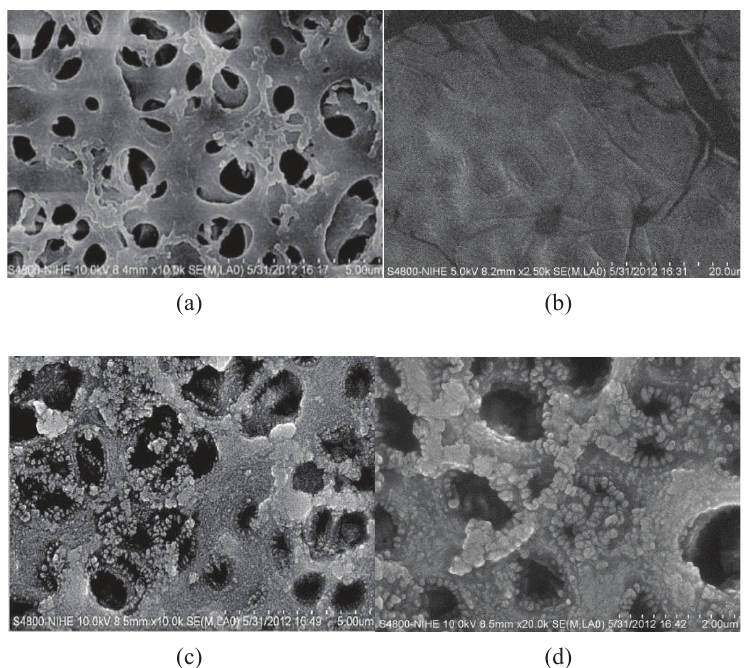
Fig. 5 – Surface of cellulose acetate membrane before and after impregnation with different ILs (a: original, b: after impreg­ nation with [OMIM][CH COO], c: after impregnation with 3 [BMIM][CH